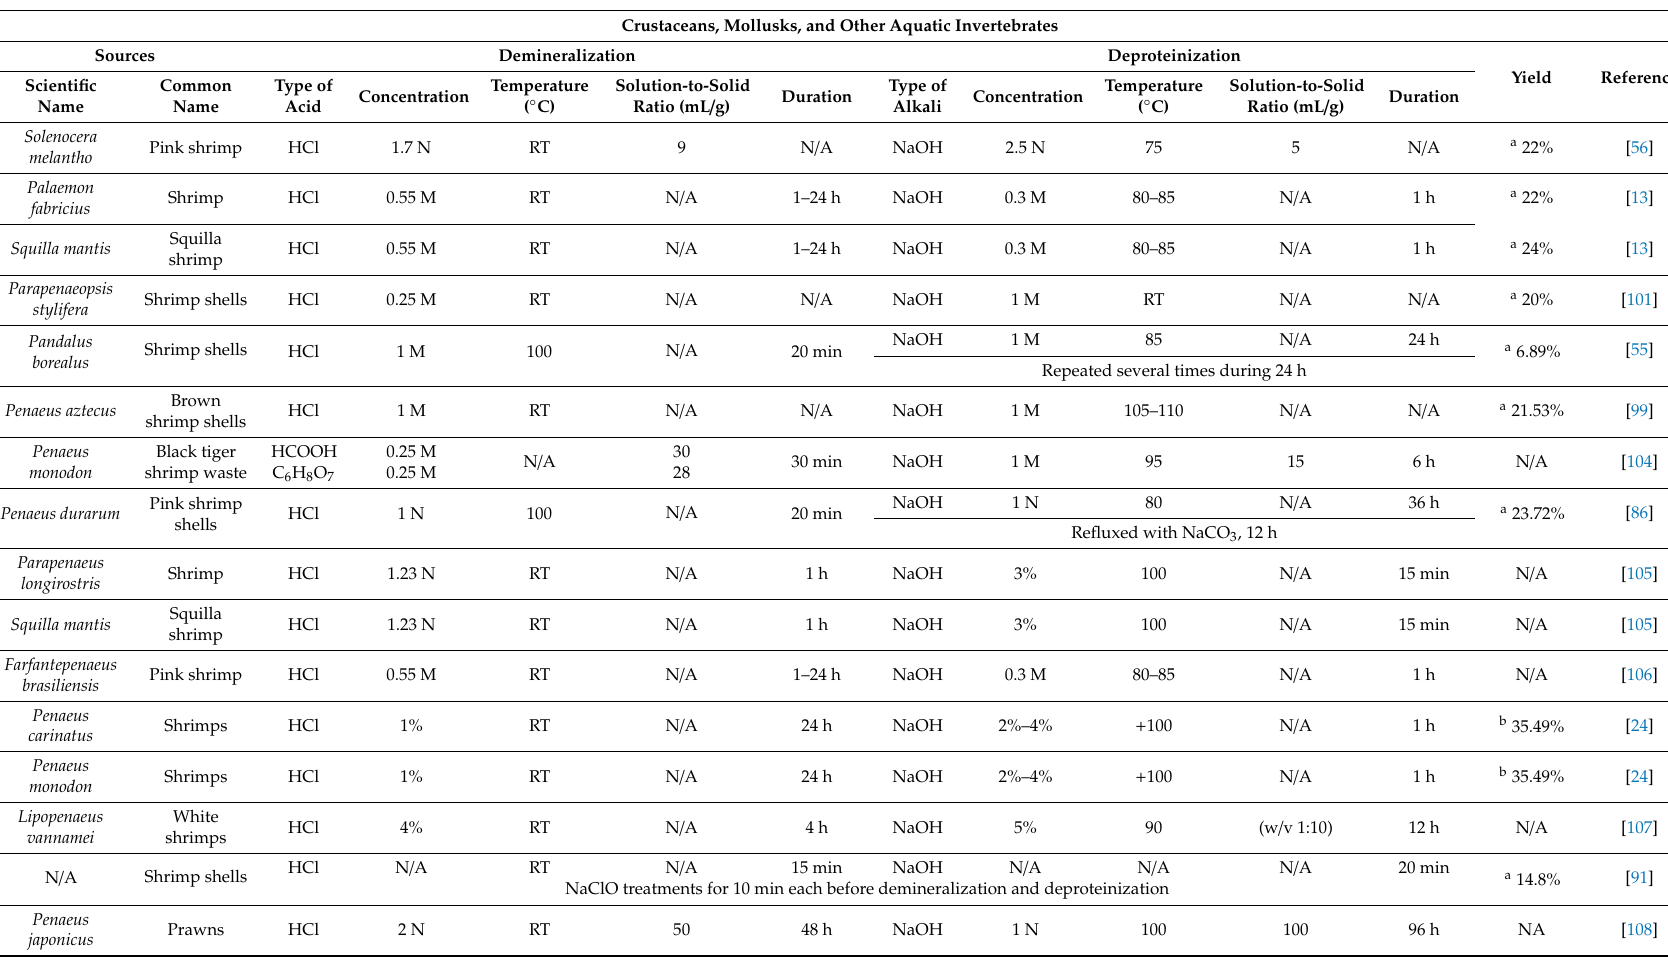
Table 2. A summary of the demineralization and deproteinization of chitin and chitosan from crustaceans, mollusks, and other aquatic